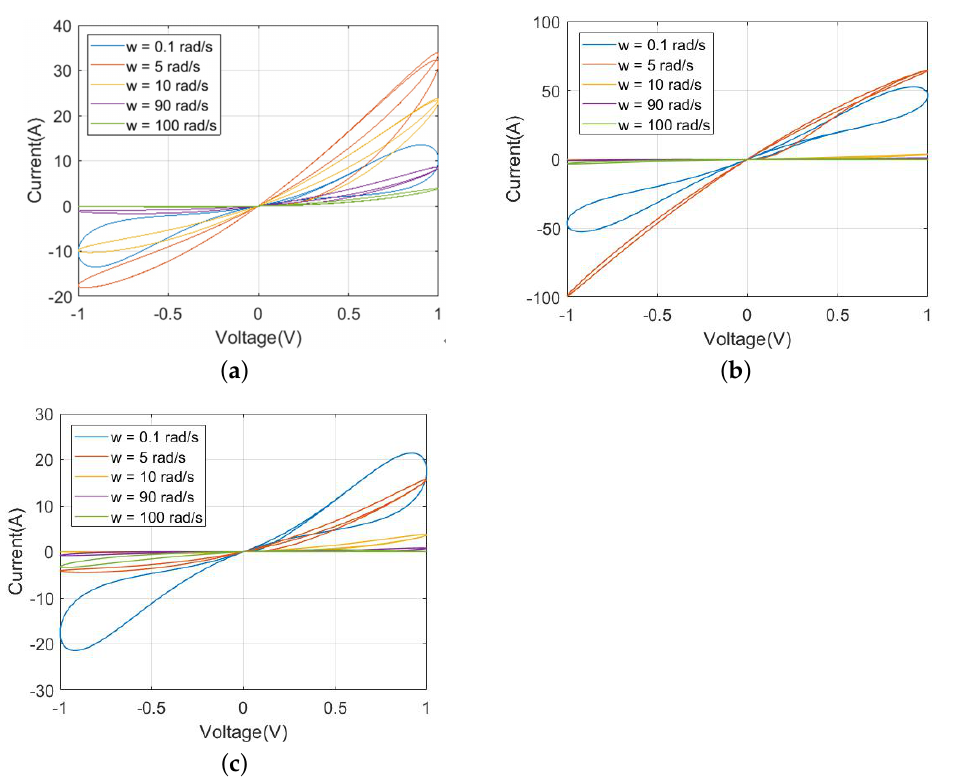
Figure 1. The coexisting pinched hysteresis loop: ( a ) A = A M ; ( b ) A = A FS < A M ; ( c ) A = A FL > A M